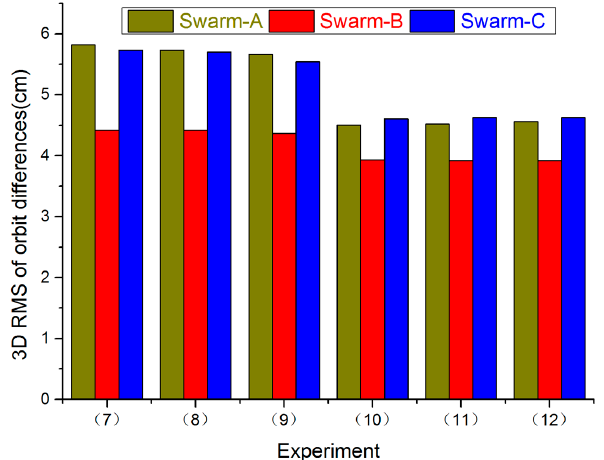
Figure 3. RMS values of orbit differences for all Swarm satellites in 3D direction between Swarm POD and PSOs released by ESA from Experiments (7) to (12), 1 November 2014.